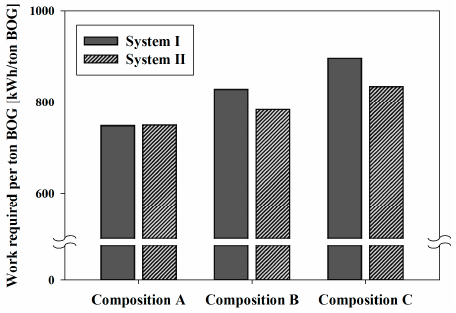
Figure 5. Variation of the energy required to liquefy the BOG based on the nitrogen content of the BOG.